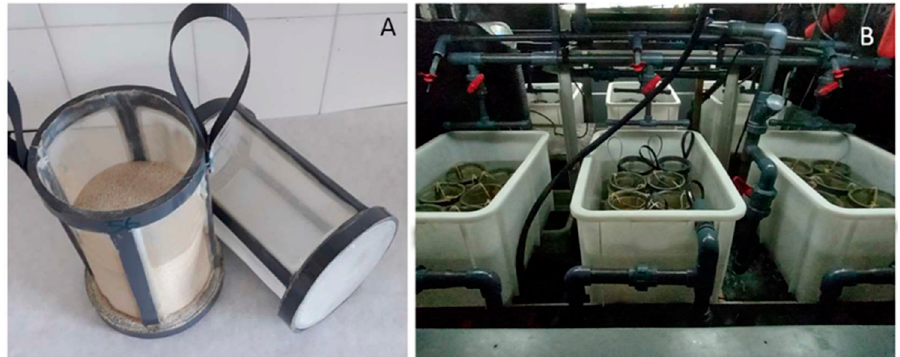
Figure 1. ( A ) Experimental units (height 20 cm; internal diameter 11.3 cm) and ( B ) RAS, including six polycarbonate trays (width 35 cm; height 30 cm; length 54 cm) in which 6–7 experimental units were